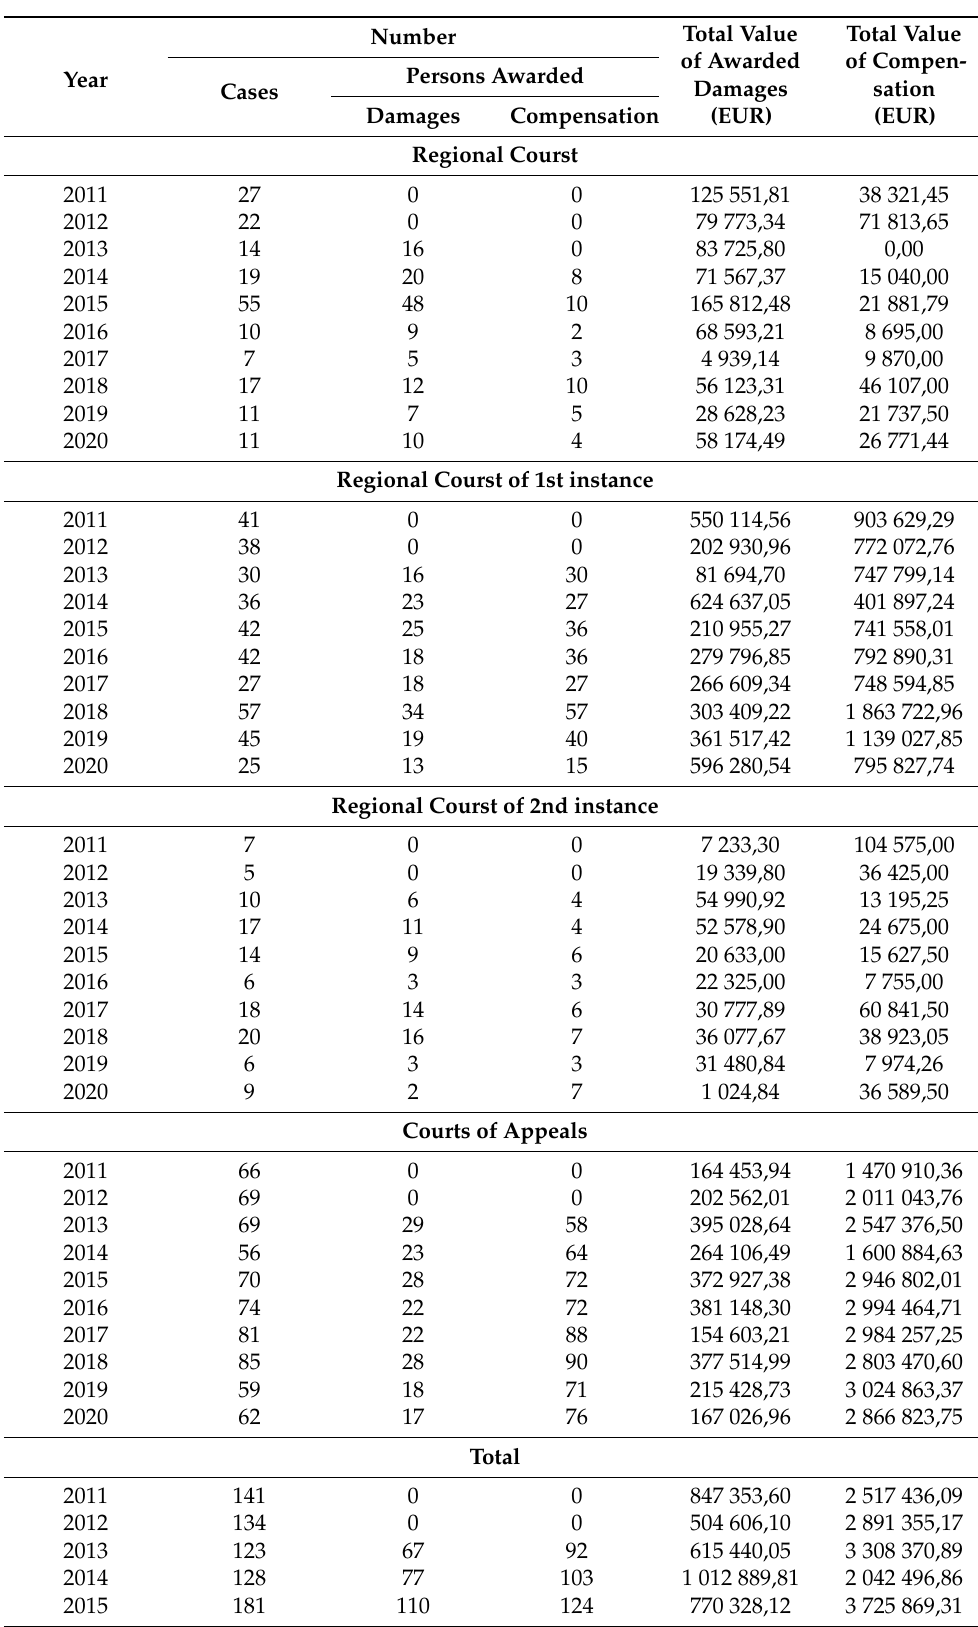
Table 4. Finally awarded compensation and damages for harm caused by the healthcare system in the years 2011–2020—own